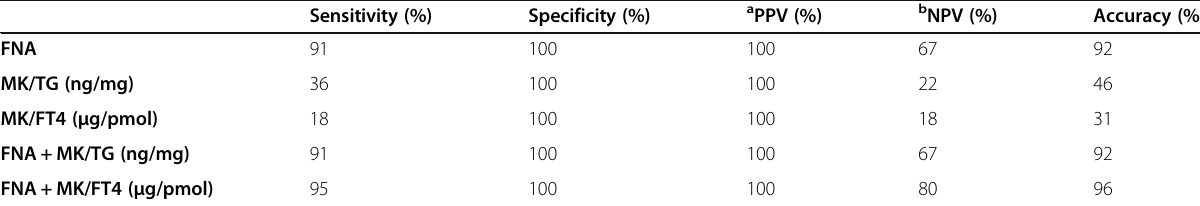
Table 6 Diagnostic utility comparison of MK ratios in combination with